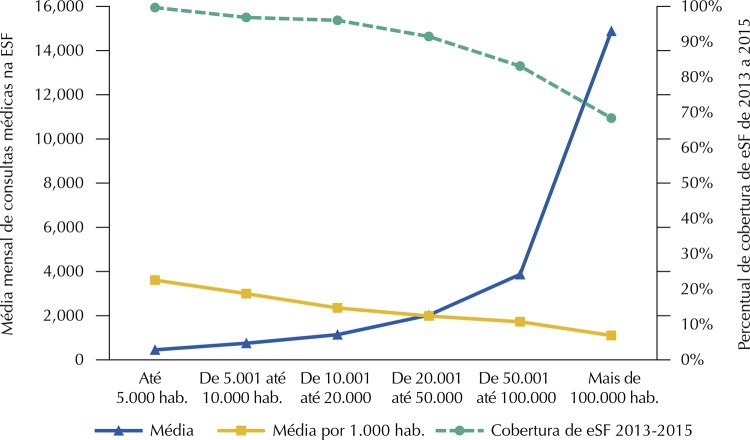
Média e média ajustada para 1.000 habitantes de consultas médicas mensais na Estratégia Saúde da Família em amostra de municípios participantes do programa Mais Médicos na região Nordeste, segundo porte populacional e percentual de cobertura de equipes de saúde da família, abril de 2013 a setembro de 2015.ESF: Estratégia Saúde da Família; eSF: equipes de saúde da família.